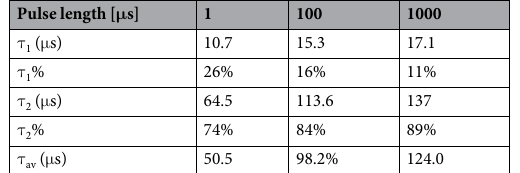
Table 1. Lifetime summary with different excitation pulse length (modulated 405 nm excitation, 80 mW peak power) for a